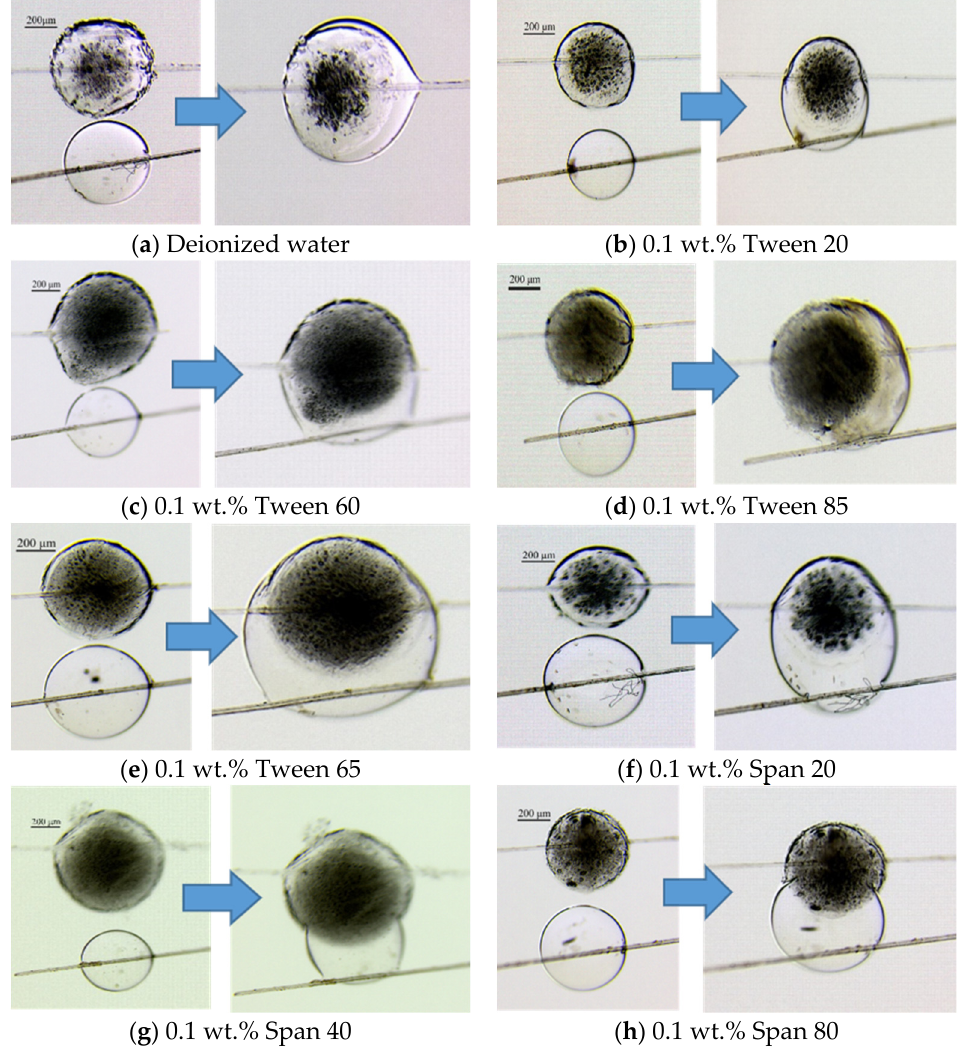
Figure 8. Wettability tests in the presence of surfactants with different HLB values.